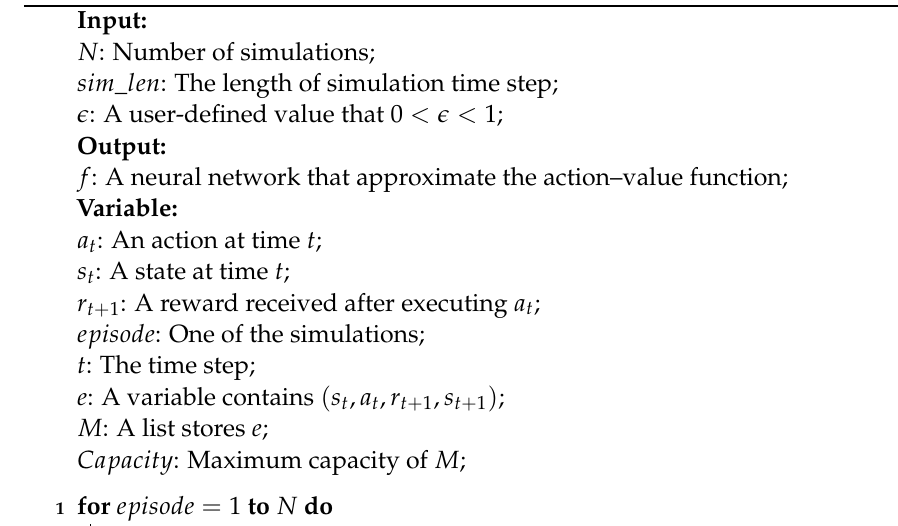
Algorithm 1: Q-Learning based intersection scheduling